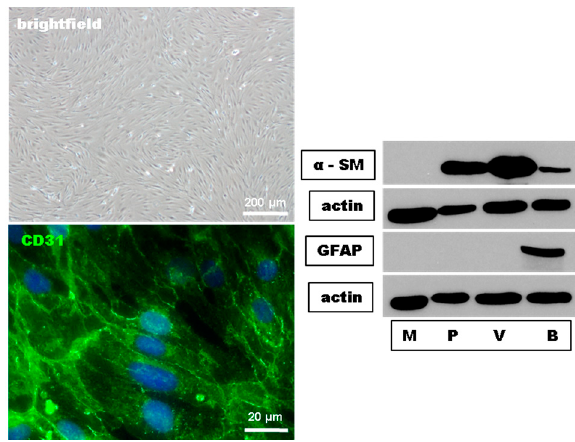
Figure 1. Histological characterization and Western blot purity control of mouse brain microvascular endothelial cells (MBMEC). Phase contrast image of confluent MBMEC revealed that the cells express a spindle-shaped morphology and a constant monolayer. Micrographs of immunofluorescence staining against Hoechst (blue) and CD31 (green). Western blot analysis of the expression of alpha smooth muscle actin ( α -SM) and Glial Fibrillary Acidic Protein (GFAP) in MBMEC (M) compared to pericytes (P), mouse brain microvessels (V), and mouse brain lysate (B). Actin was used as loading control.